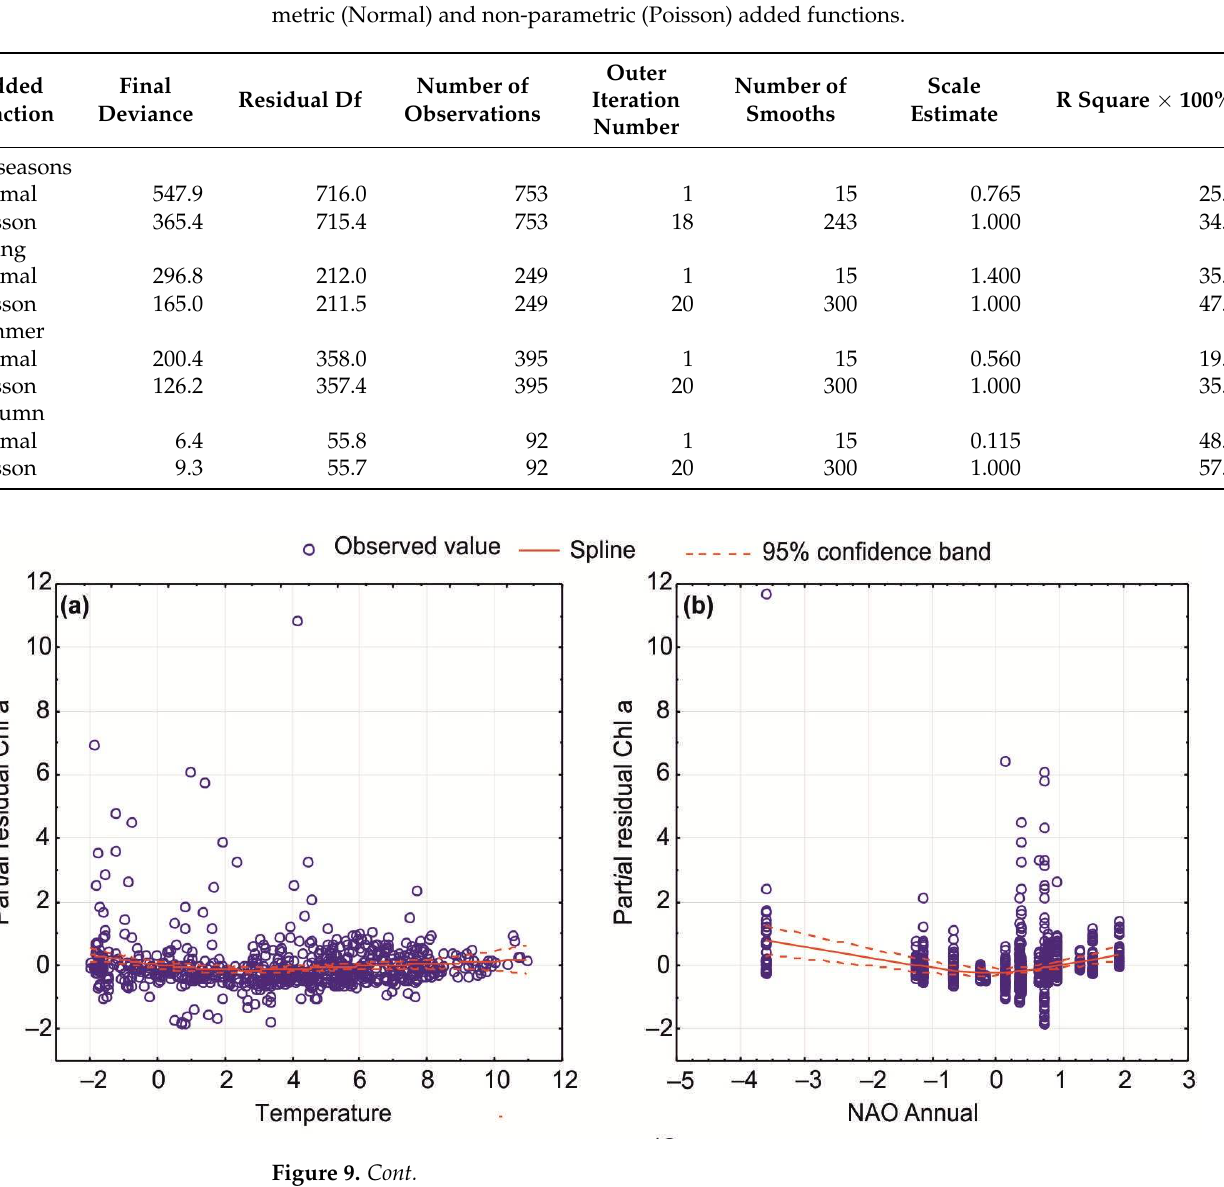
Figure 9. Significant GAM results (parametric, normal added functions) for Chl ‐ a as a response variable in relation to climatic predictors as explanatory variables in the Barents Sea during the period 1984–2021. Smoothed best ‐ fit lines with 95% confidence intervals for combined data (all